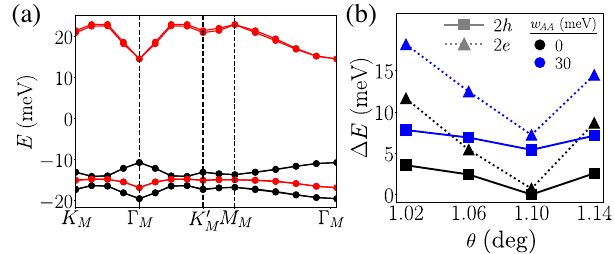
FIG. 10. Paired skyrmions (spinful ν ¼ þ 2 ). (a) Hartree-Fock dispersion of spin-polarized KIVC insulator at ν ¼ þ 2 . Red (black) indicates minority (majority) spin carrier. System size is 24 × 24 with θ ¼ 1 . 06 °. (b) Relative energy Δ E ¼ E ˆ T 0 E -symmetric paired 2 e and 2 h skyrmions about 2 e ð h Þ of ν ¼ þ 2 . Note the sharp minimum of unfilled band at Γ size is 11 × 11 with the CN